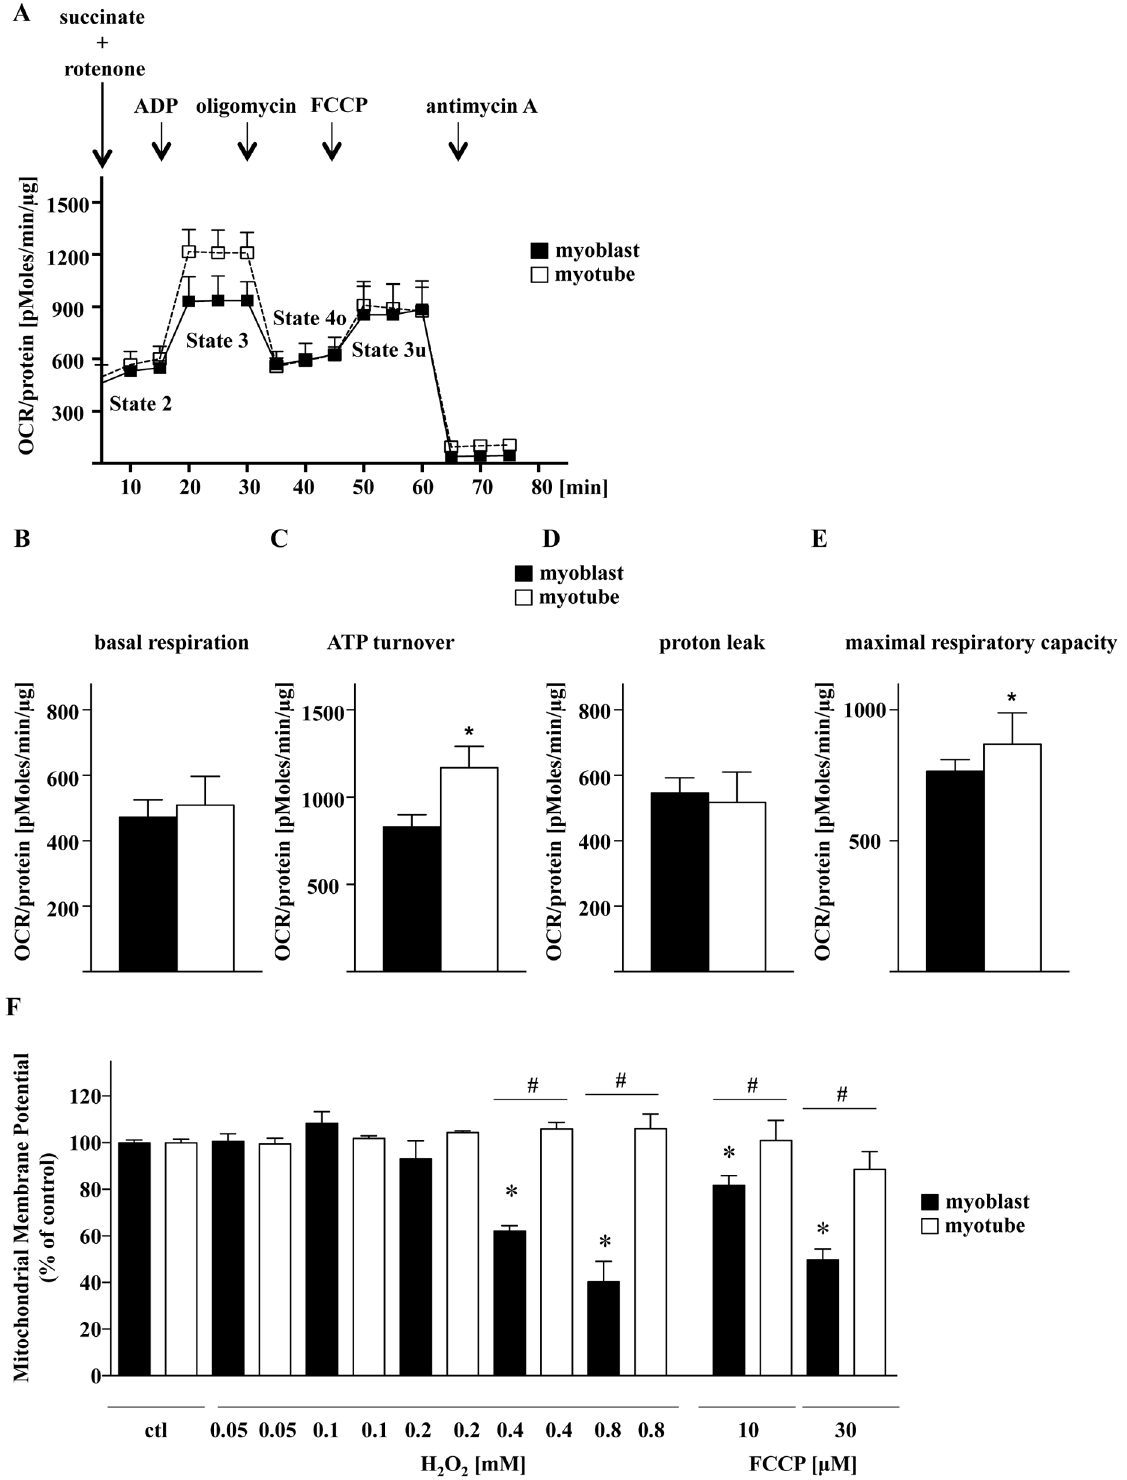
Fig 8. Cellular bioenergetics of mitochondria isolated from myoblasts and myotubes. Bioenergetic analysis was carried out using the Extracellular Flux Analyzer (Seahorse XF-24) in response to the sequential administration of ADP (4 mM), oligomycin (2 μ M), FCCP (4 μ M), and antimycin A (4 μ M) in the presence of succinate (5.5 mM) and rotenone (2 μ M). (A) Representative analysis of oxygen consumption. Calculated bioenergetics parameters: (B) basal respiration, (C) ATP turnover, (D) proton leak and (E) maximal respiratory capacity. Data are shown as means ± SD of n = 9 wells collected from n = 3